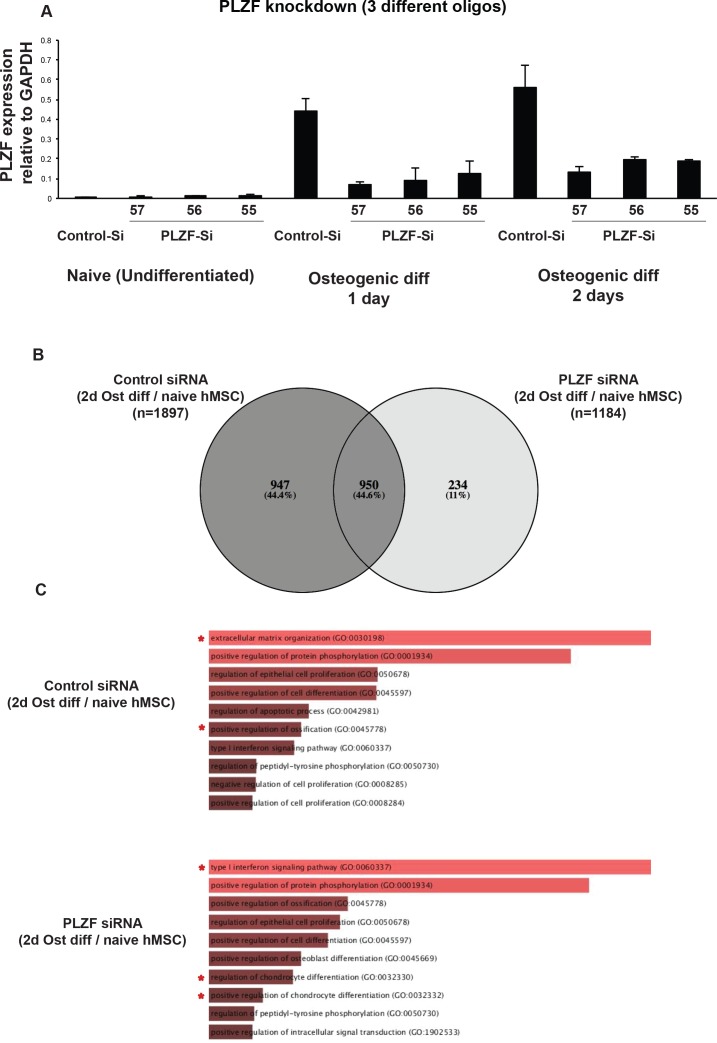
(A) PLZF knockdown using three different siRNA (55, 56, 57) in hMSCs measured by RT-QPCR.hMSCs were transfected with siRNA oligos against PLZF or scrambled control oligo as indicated. After 24 hr the medium was changed and osteogenic differentiation was induced for 2 days. Relative mRNA levels were calculated after normalization to GAPDH. Data is mean ± SD from triplicates of QPCR experiment. The siRNA oligos were ordered from Sigma mission and oligo IDs are given in Supplementary file 9. (B) The Venn diagram shows the overlap between differentially regulated genes upon induction of osteogenic differentiation from RNA seq analyses in hMSCs, in the presence or absence of PLZF. The diagram was generated using online tool Venny (Oliveros, 2007). (C) The bar graphs show the Gene Ontology (GO, Biological processes) terms enriched for differentially regulated genes from each group; control siRNA or PLZF siRNA transfected hMSCs upon induction of osteogenic differentiation (2d vs naive). The online tool Enrichr was used for the analyses (Chen et al., 2013; Kuleshov et al., 2016). The values in the graph are combined scores computed by multiplying the p-value (Fischer exact test) with z-score of the deviation from the expected rank.